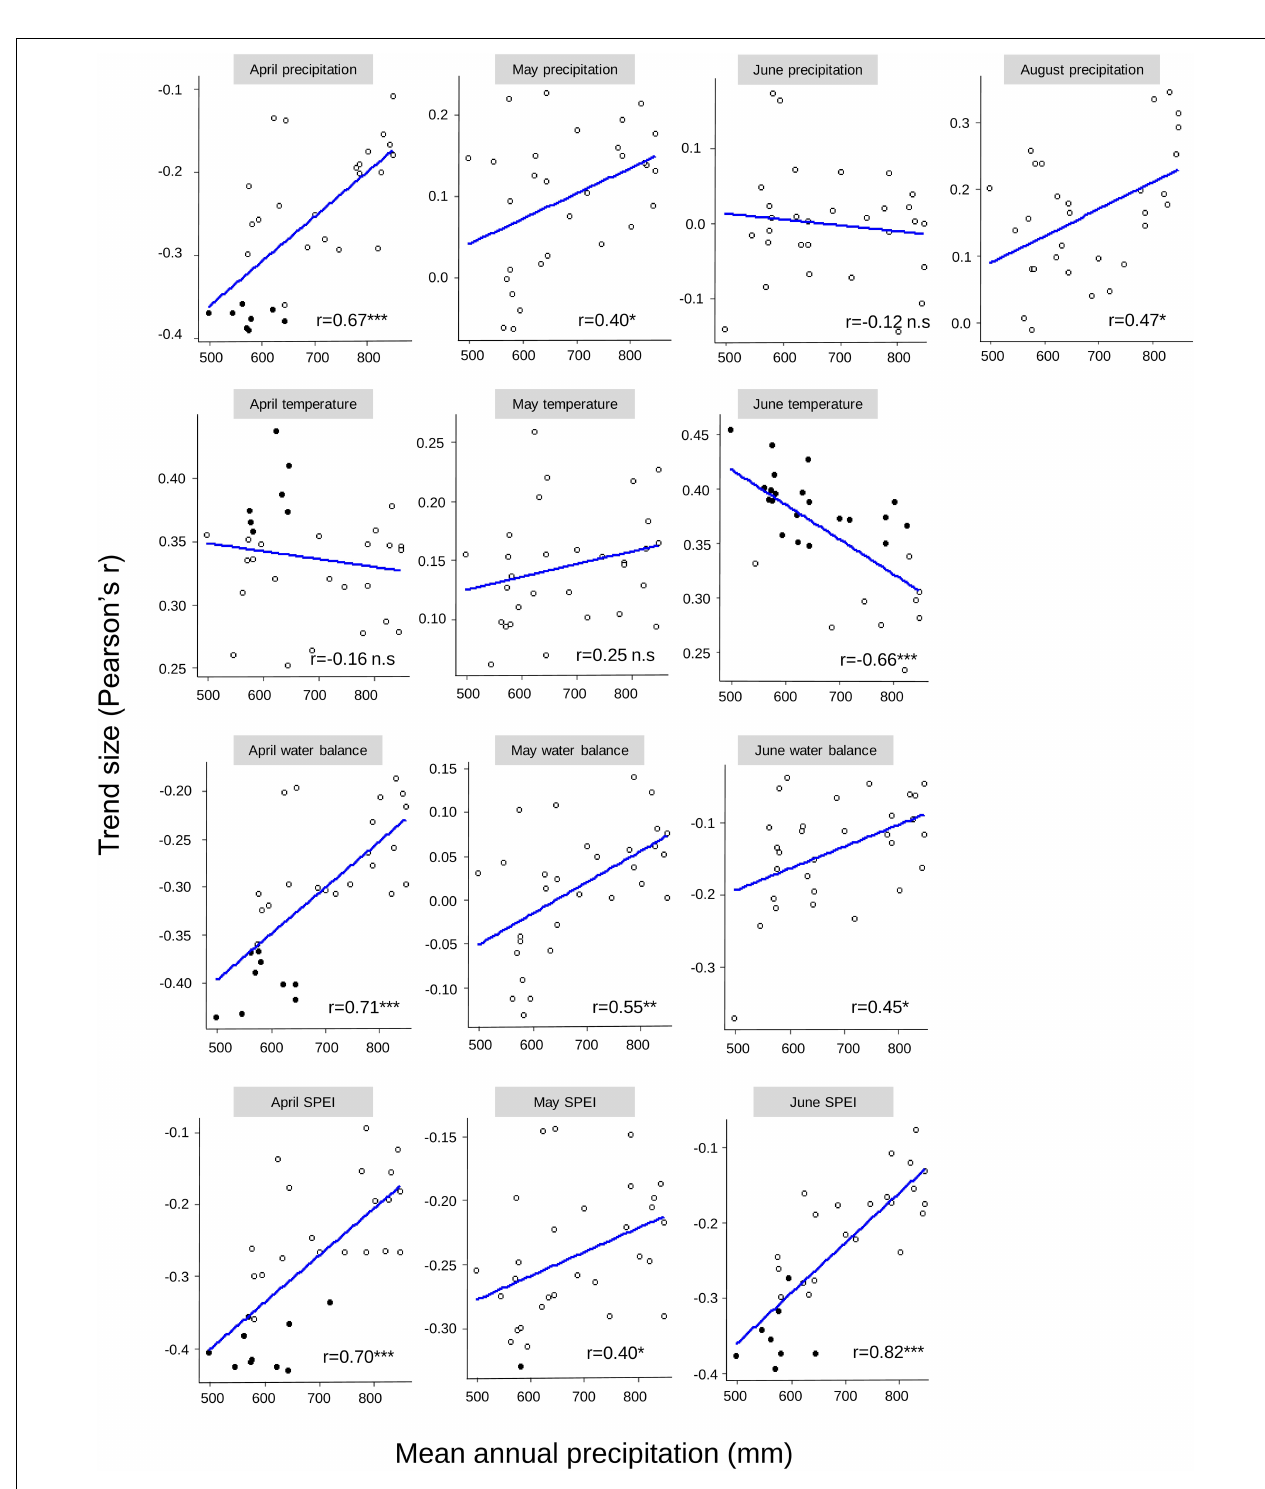
Frontiers in Forests and Global Change |